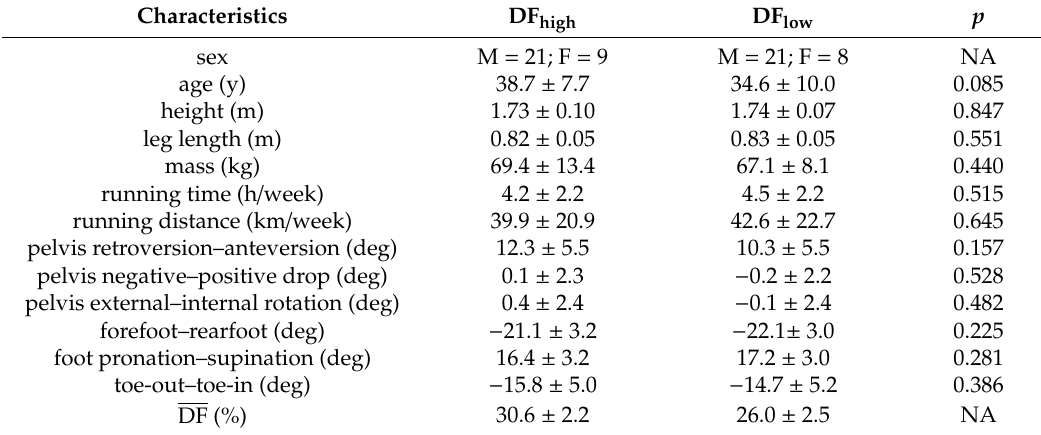
Table 1. Participant characteristics for the high (DF high ) and low (DF low ) duty factor running groups.